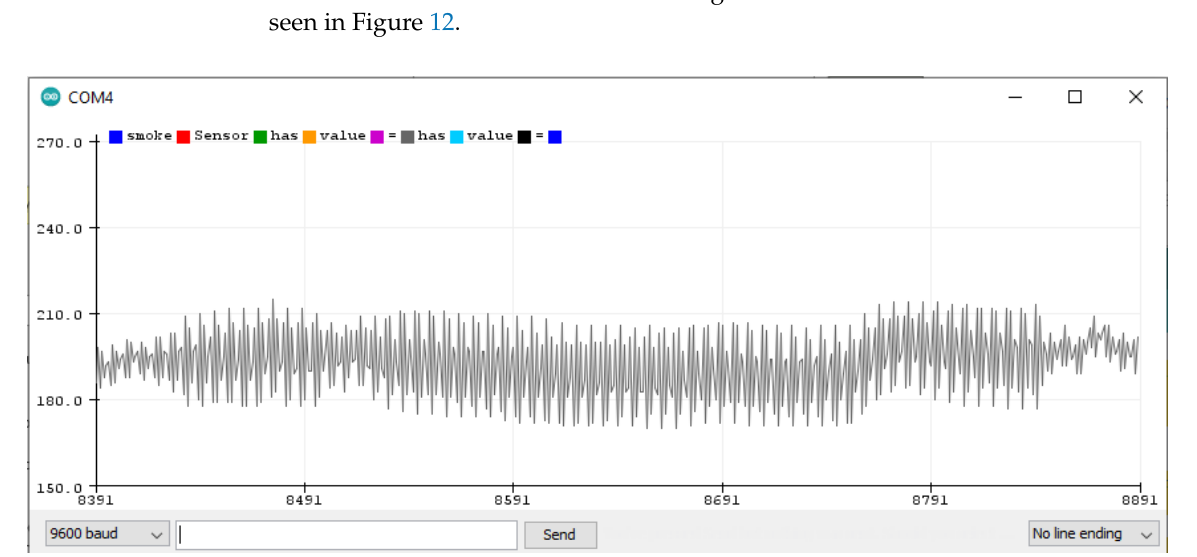
Figure 12. Smoke detector’s waveform when there is no smoke. Fire or smoke are found in the 230 to 270 sensor range, as seen in Figure 13. After performing several experiments, it is noticed that a value greater than 240 (the threshold) indicates fire.